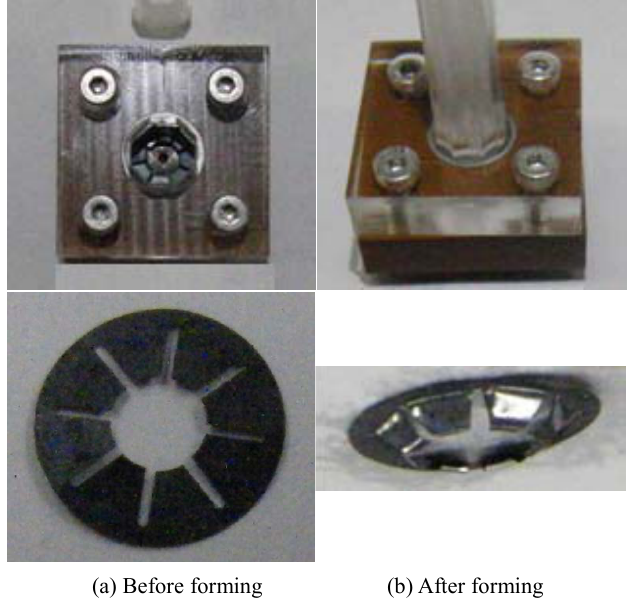
Figure 11. Actual forming of an SMA octagonal-pyramidal foil transducer.